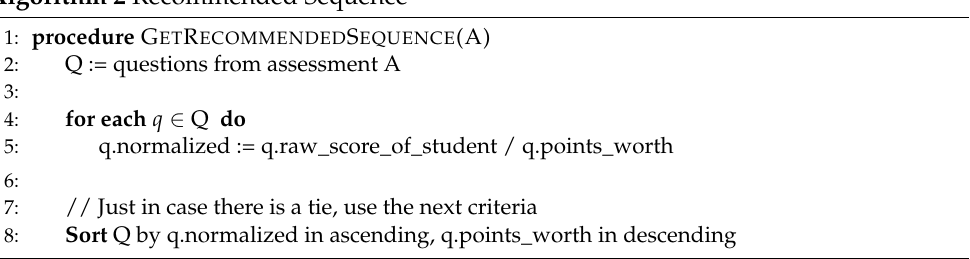
Algorithm 2 Recommended Sequence